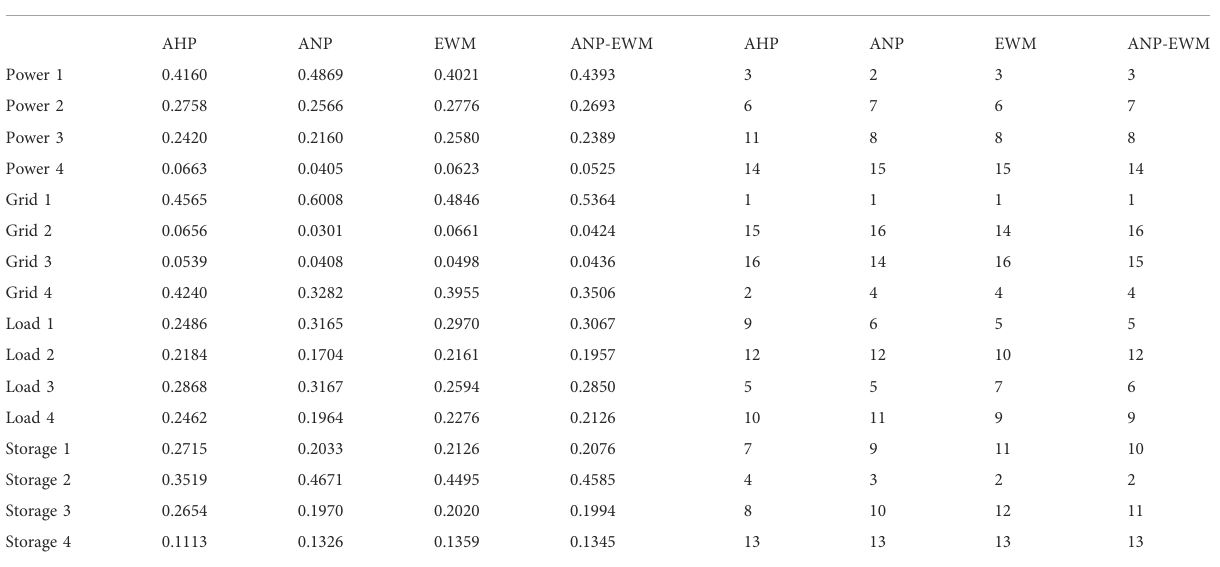
TABLE 6 Integrated investment decision results for different weighting